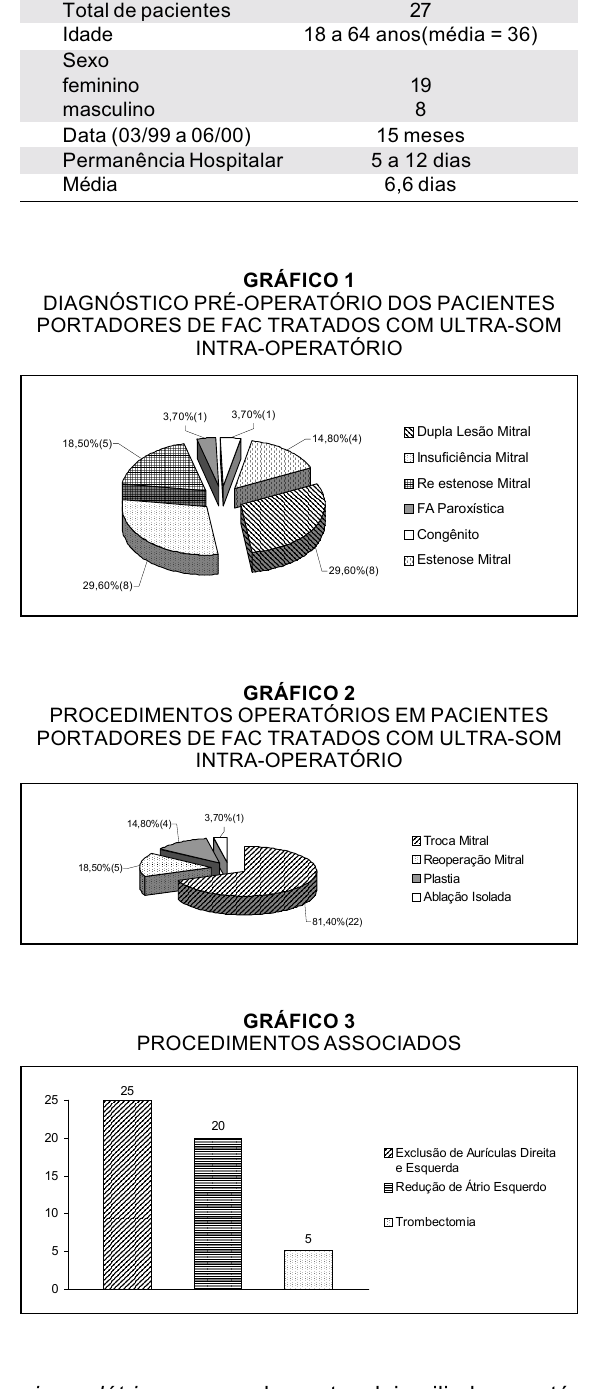
piezo-elétricas prensadas entre dois cilindros metá- licos. O transdutor é preso ao amplificador acústico que, por sua vez, é preso ao extensor das hastes, onde se encaixam os